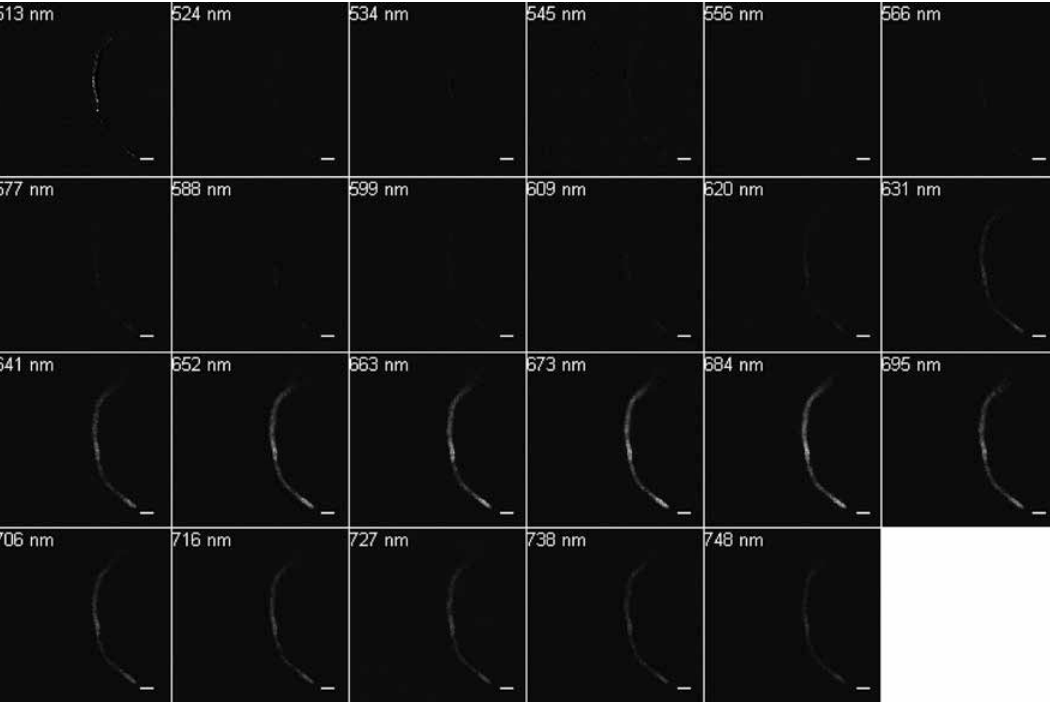
Figure 4. Spectral emission collection of SF33 RL-grown cells after excitation with 488-nm laser. An emission spectrum was gathered at 10.7-nm increments in the range from 500 nm to 750 nm. All images at 63× oil objective. Bars, 10